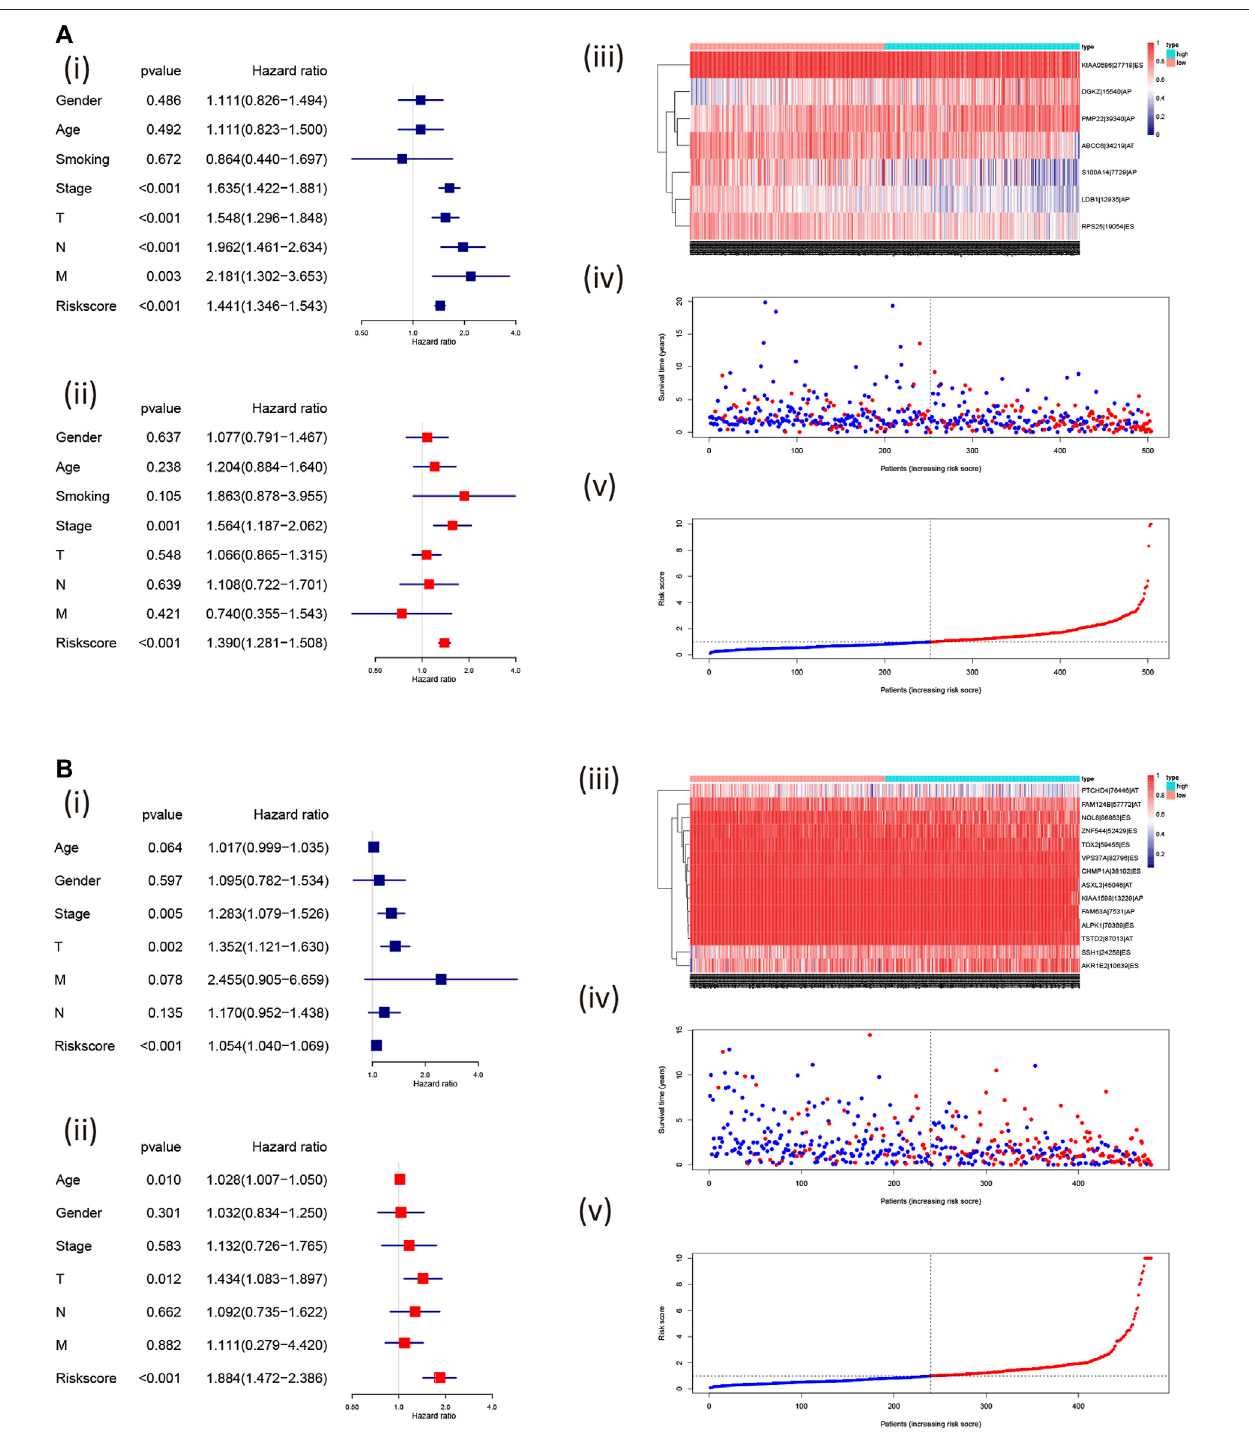
FIGURE 7 | Assessment of the independent prognostic value using the risk scores. The univariate and multivariate Cox regression analyses of the risk signature in LUAD (A) ; i,univariate and ii,multivariate Coxregression analyses and in LUSC (B) ; i, univariate and ii, multivariate Cox regression analysesrisk signature. The visualized genepercentsplicedindexvalueinLUAD( A ;iii)andLUSC( B ;iii)andriskscoreswereassociatedwithNSCLCsurvival[LUAD: (A) :iv,v;LUSC: (A) :iv,v;thereddotorline represents the deceased, while the blue dot or line represents alive]. LUAD, lung adenocarcinoma; LUSC, lung squamous cell carcinoma; PSI, percent spliced in